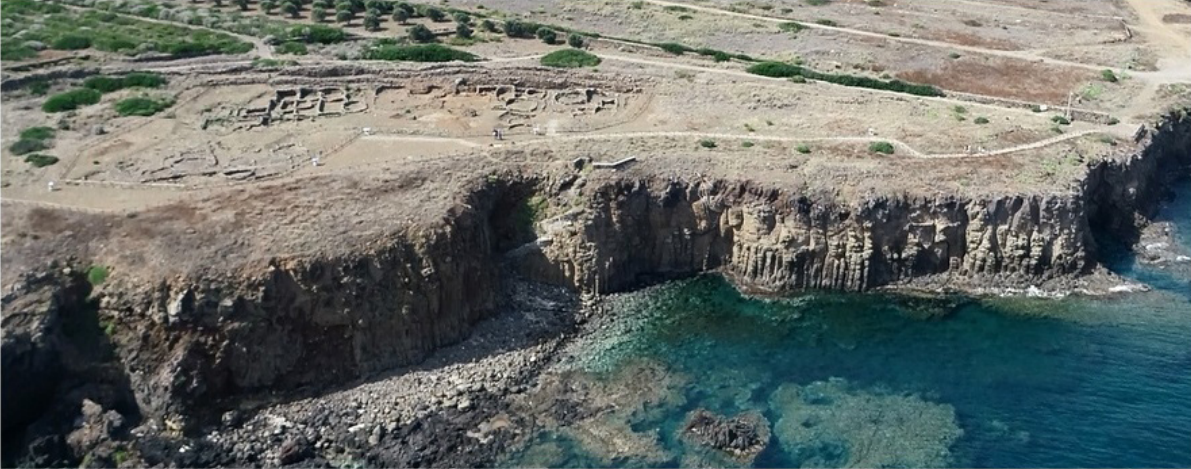
Figure 6: Aerial view of the Middle Bronze Age I Faraglioni village, in the northern sector of Ustica. In the central-left part of the photo are the huts revealed by archaeological excavations (courtesy of INGV Remote Sensing Laboratory, Rome,